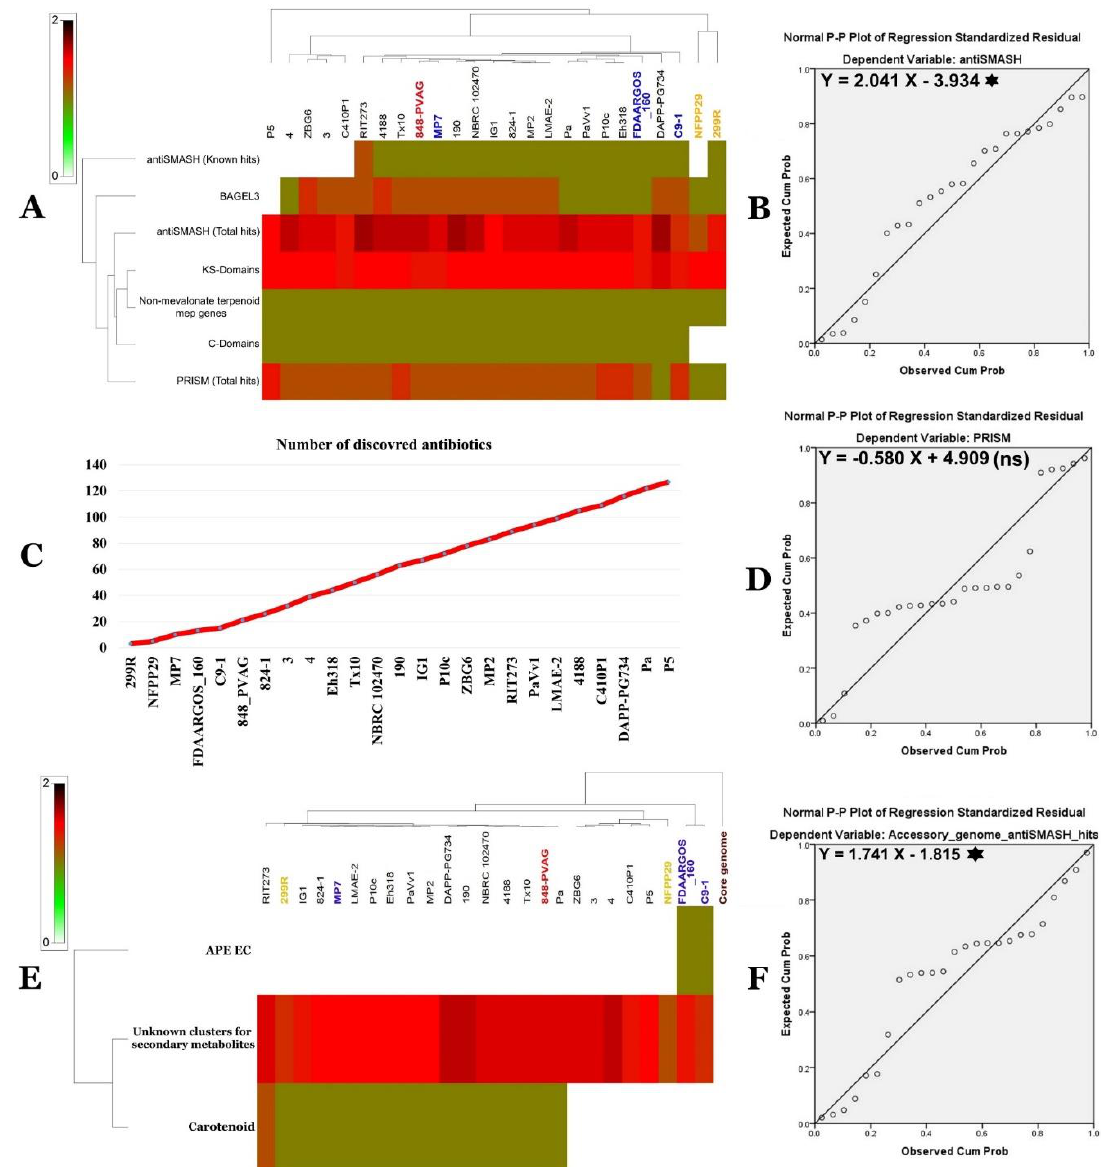
Figure 11. Secondary metabolite arsenal of P. agglomerans and P. vagans isolates and its relationship to genome size and accessory genomes. ( A ) Genome mining of secondary metabolite clusters illustrated by a heat map. ( B ) Linear relationship between antiSMASH total hits and genome sizes (*: statistically significant at p < 0.05). ( C ) Evolution of the number of discovered secondary metabolites in relation to the number of genomes sequenced. ( D ) Linear relationship between PRISM total hits and genome sizes (statistically non-significant). ( E ) Genome mining of secondary metabolite clusters in P. agglomerans and P. vagans accessory genomes illustrated by a heat map. ( F ) Linear relationship between antiSMASH total hits and sizes of the accessory genomes (*: statistically significant at p <